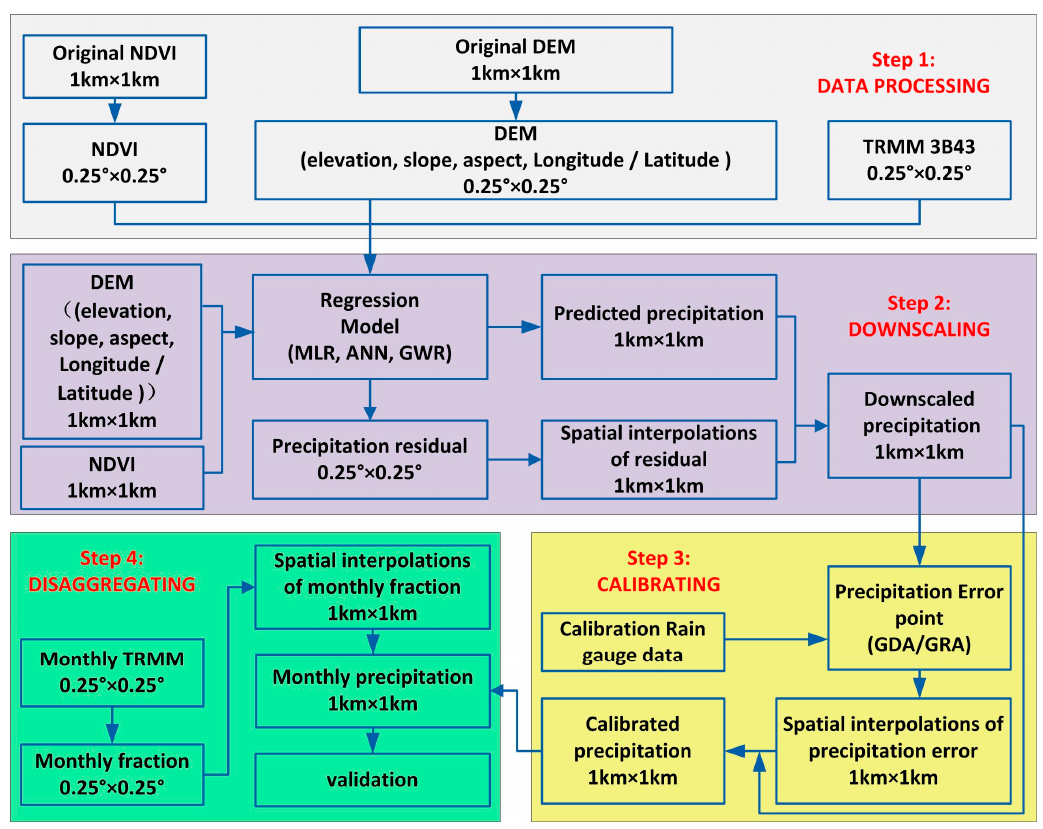
Figure 4. Flowchart of the downscaling-calibration algorithm used in the study.